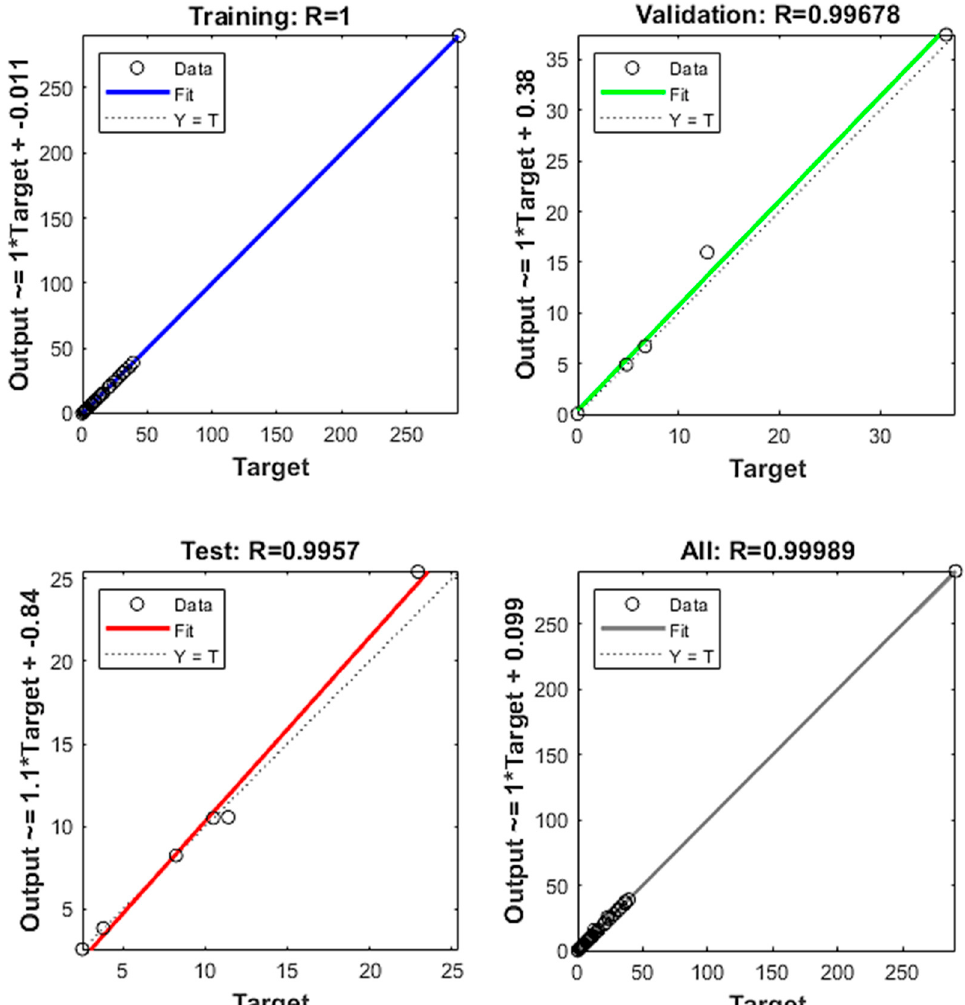
Figure 14. Comparison of the predicted and observed TEC values for training, validation, and testing phases in the wet